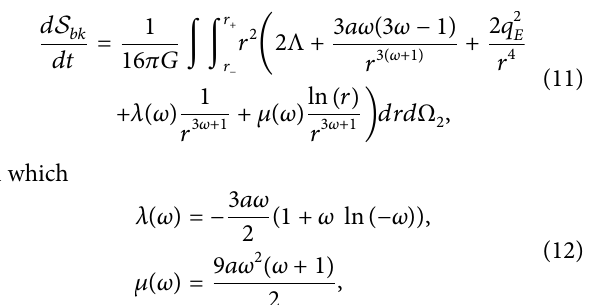
= t and t = 0. r is the null spatial L R 0 ∞